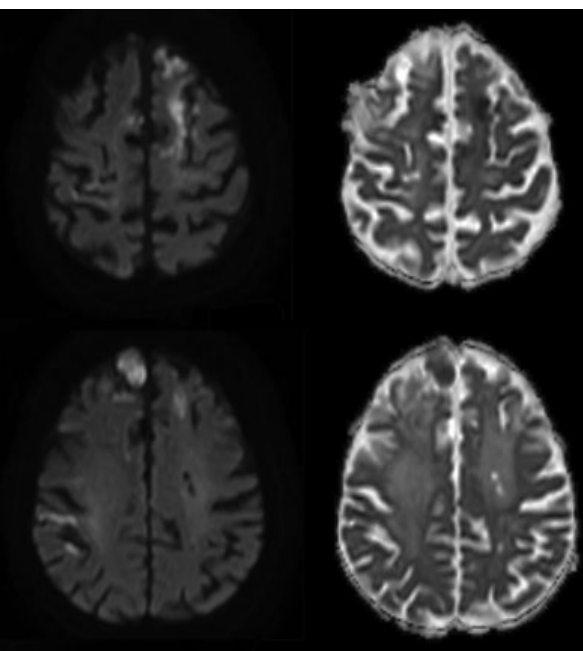
Fig. 6 MRI on the left side diffusion-weighted imaging (DWI), on the right side apparent diffusion coef fi cient (ADC) showing multiple bilateral infarcts of various age as a result of progressive disease in the course of 1 year and 8 months after the fi rst hospital admission.